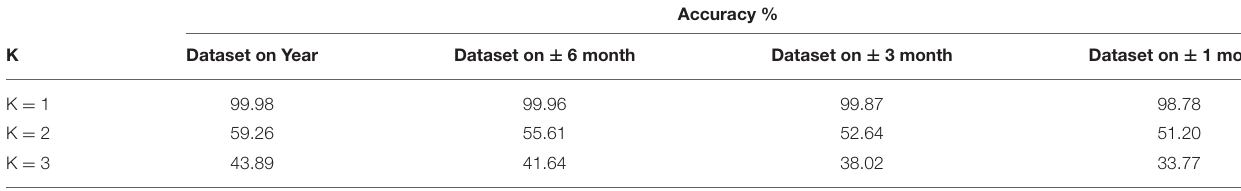
TABLE 4 | Accuracy results of K = 1, 2, 3 on the validation data.